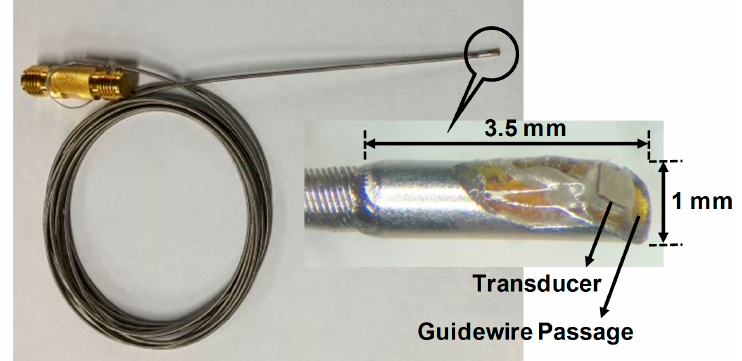
Figure 3. Photographs of the finished FL–IVUS transducer and the zoomed-in version of the white solid circle.